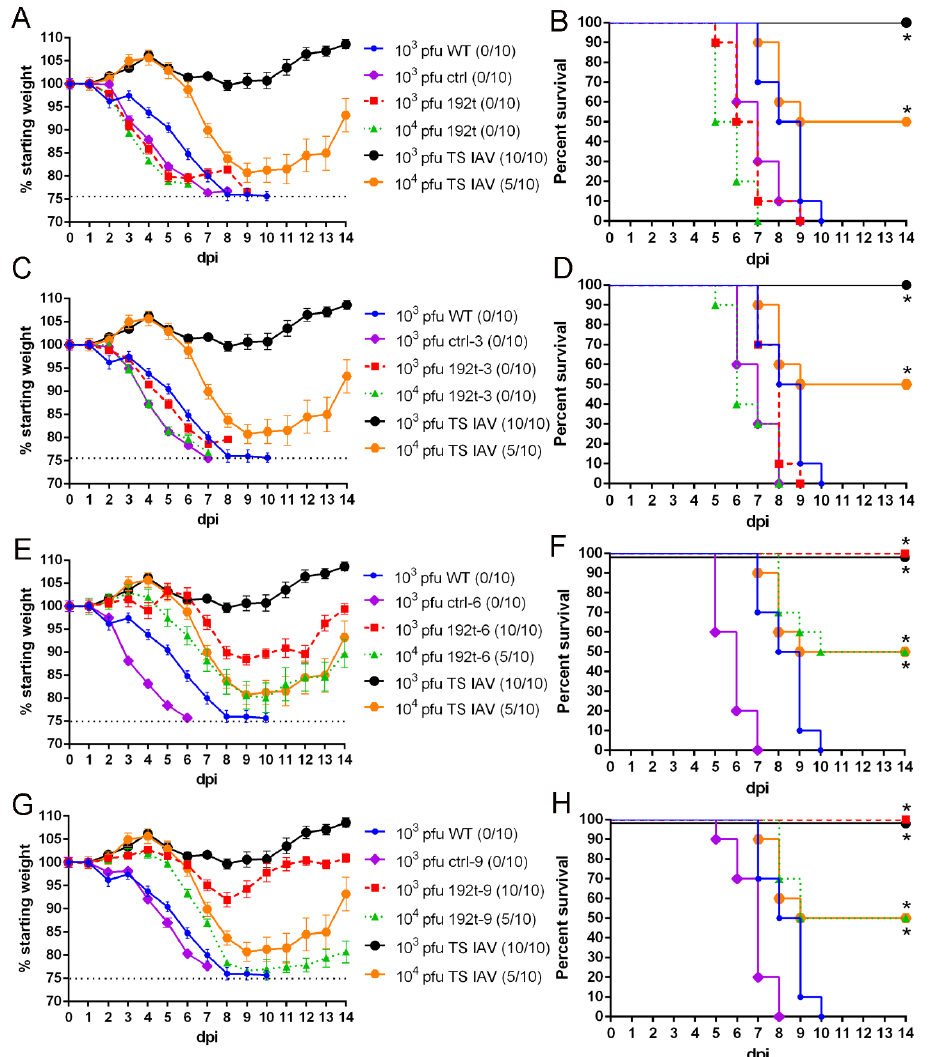
Figure 3. miR-192 targeted viruses of 192t-6 and 192t-9 are attenuated in mice. Mice were i.n. infected with 10 3 plaque-forming units (pfu) or 10 4 pfu of miR-192 targeted viruses, and with 10 3 pfu of ctrl, ctrl-3, ctrl-6, ctrl-9 and WT. Bodyweight changes ( A , C , E , G ) and survival rates ( B , D , F , H ) of mice were measured daily for two weeks after infection. * p < 0.05, compared to the WT group. Abbreviation: dpi, days